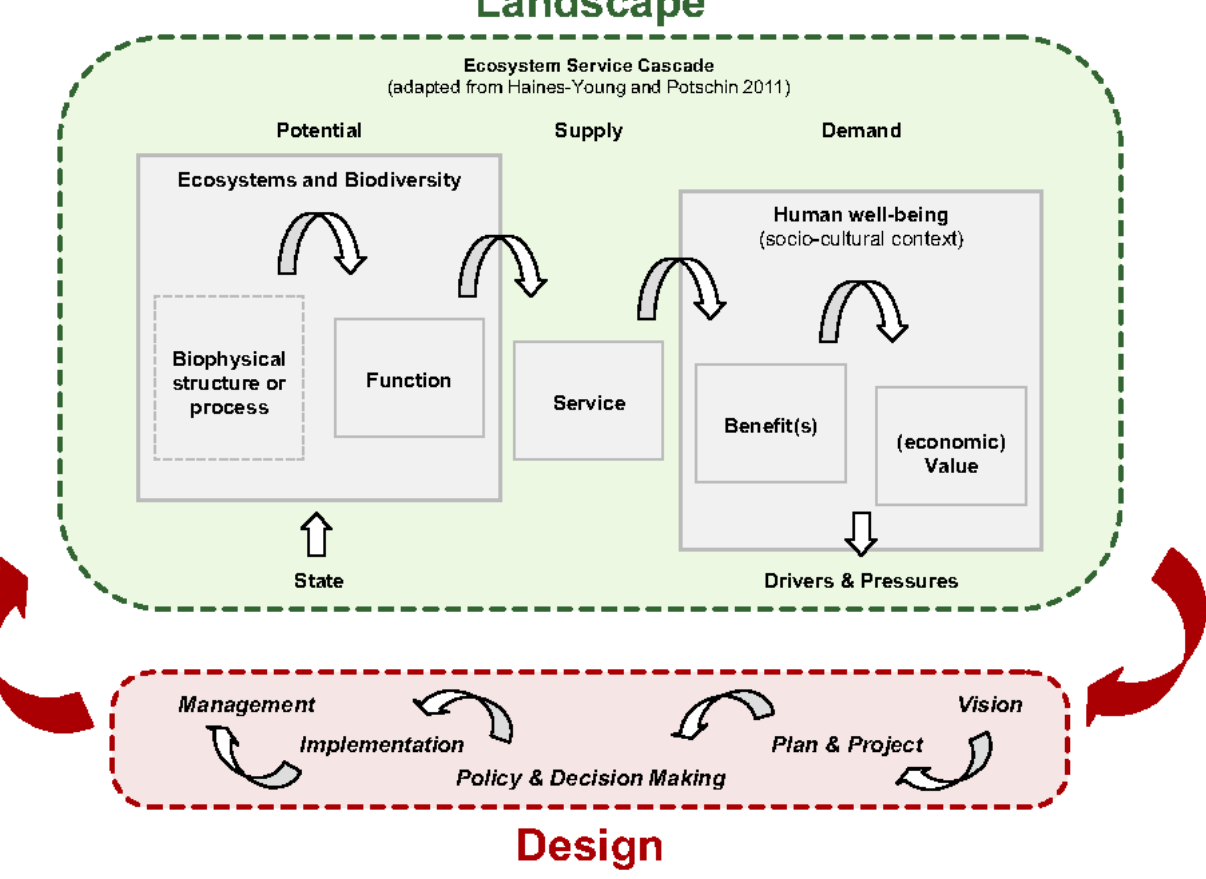
Figure 2. Landscape design for genuine landscape change to meet the societal demand for ES. Landscape as the place where it happens and Design as a mode of inquiry to activate